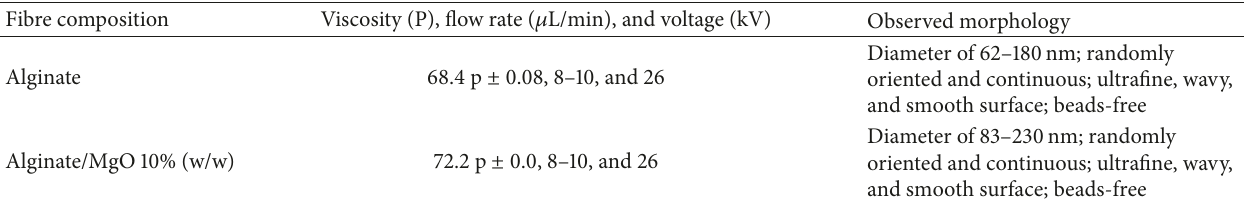
Diameter of 62–180nm; randomly oriented and continuous; ultrafine, wavy, and smooth surface; beads-free Diameter of 83–230 nm; randomly oriented and continuous; ultrafine, wavy, and smooth surface;